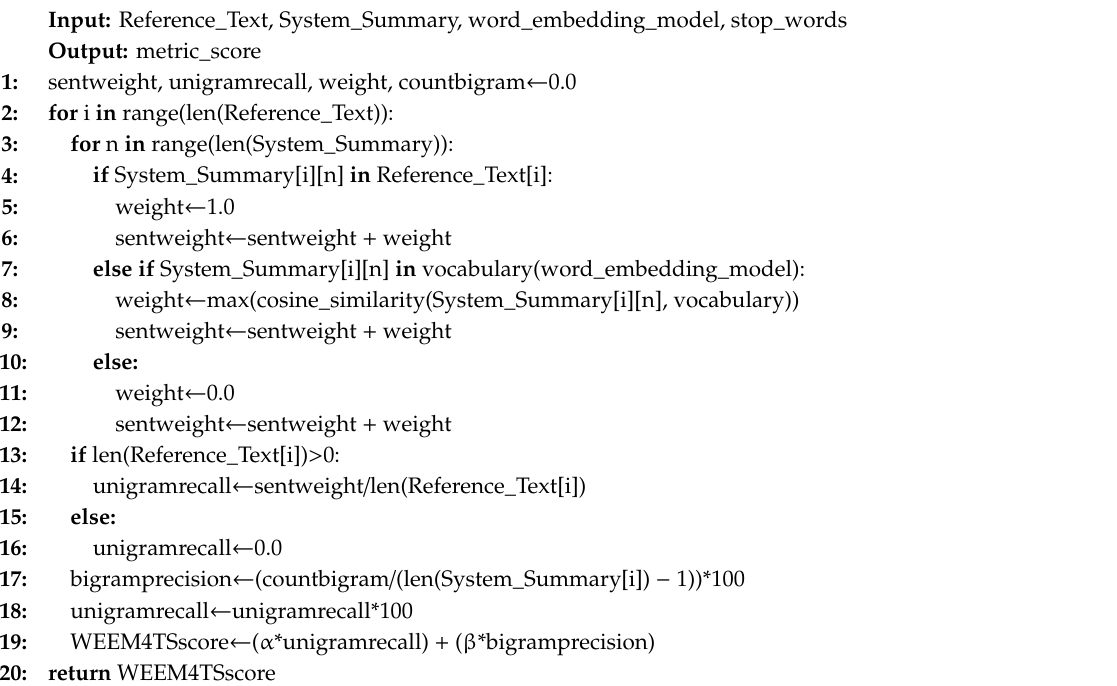
Algorithm 2: Word Embedding based Evaluation Metric for Text